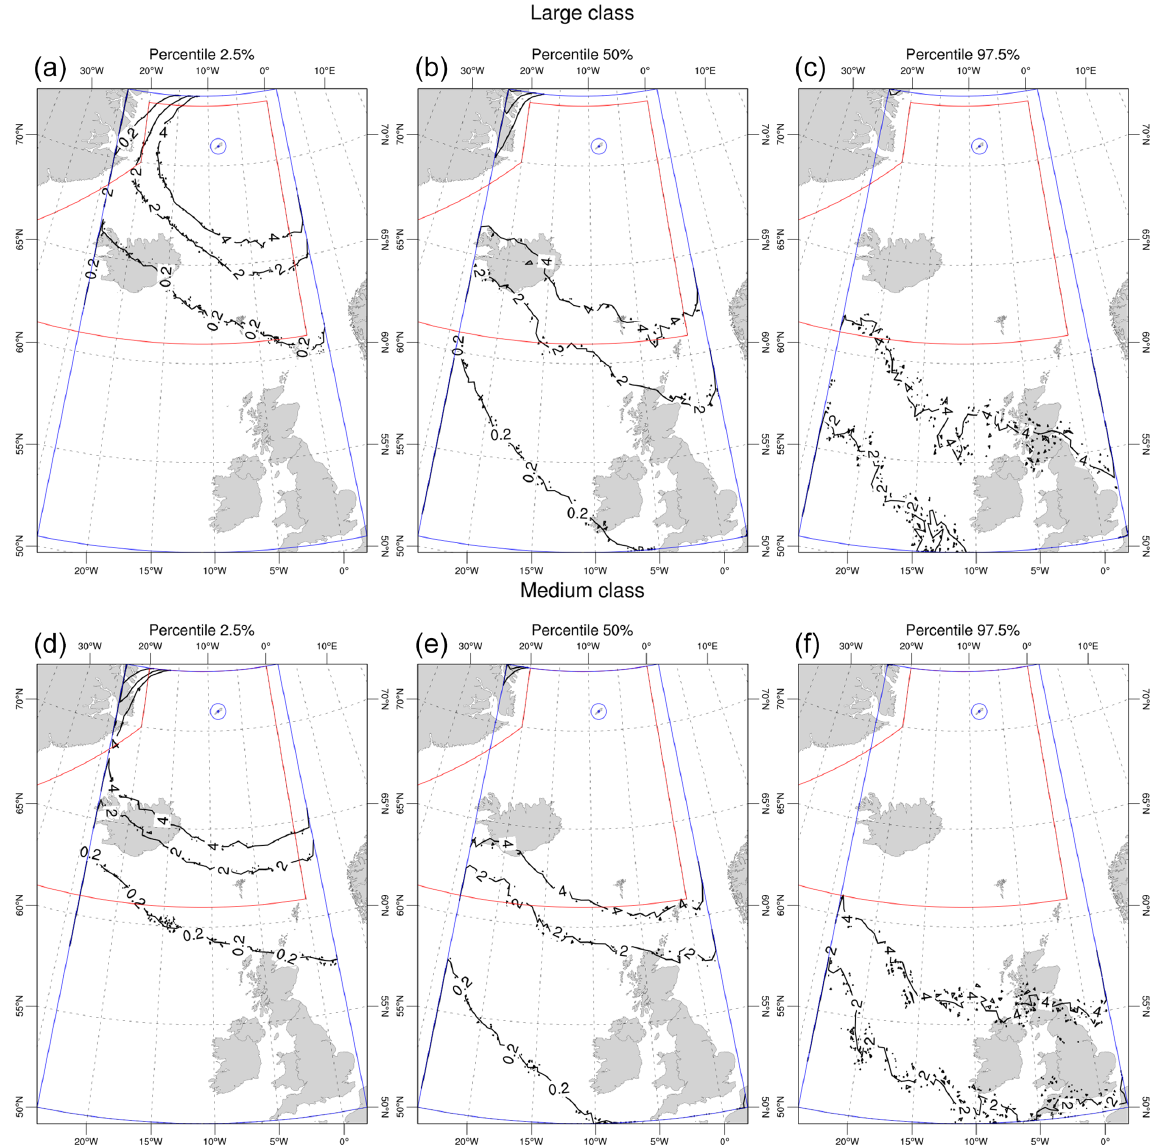
Figure 10. Concentration extent hazard map at FL050: relative uncertainties related to airborne ash cloud concentrations above 0.2, 2, and 4mgm − 3 and extent. Each map corresponds to a different level of confidence, produced by cutting the point-wise hazard curves at different